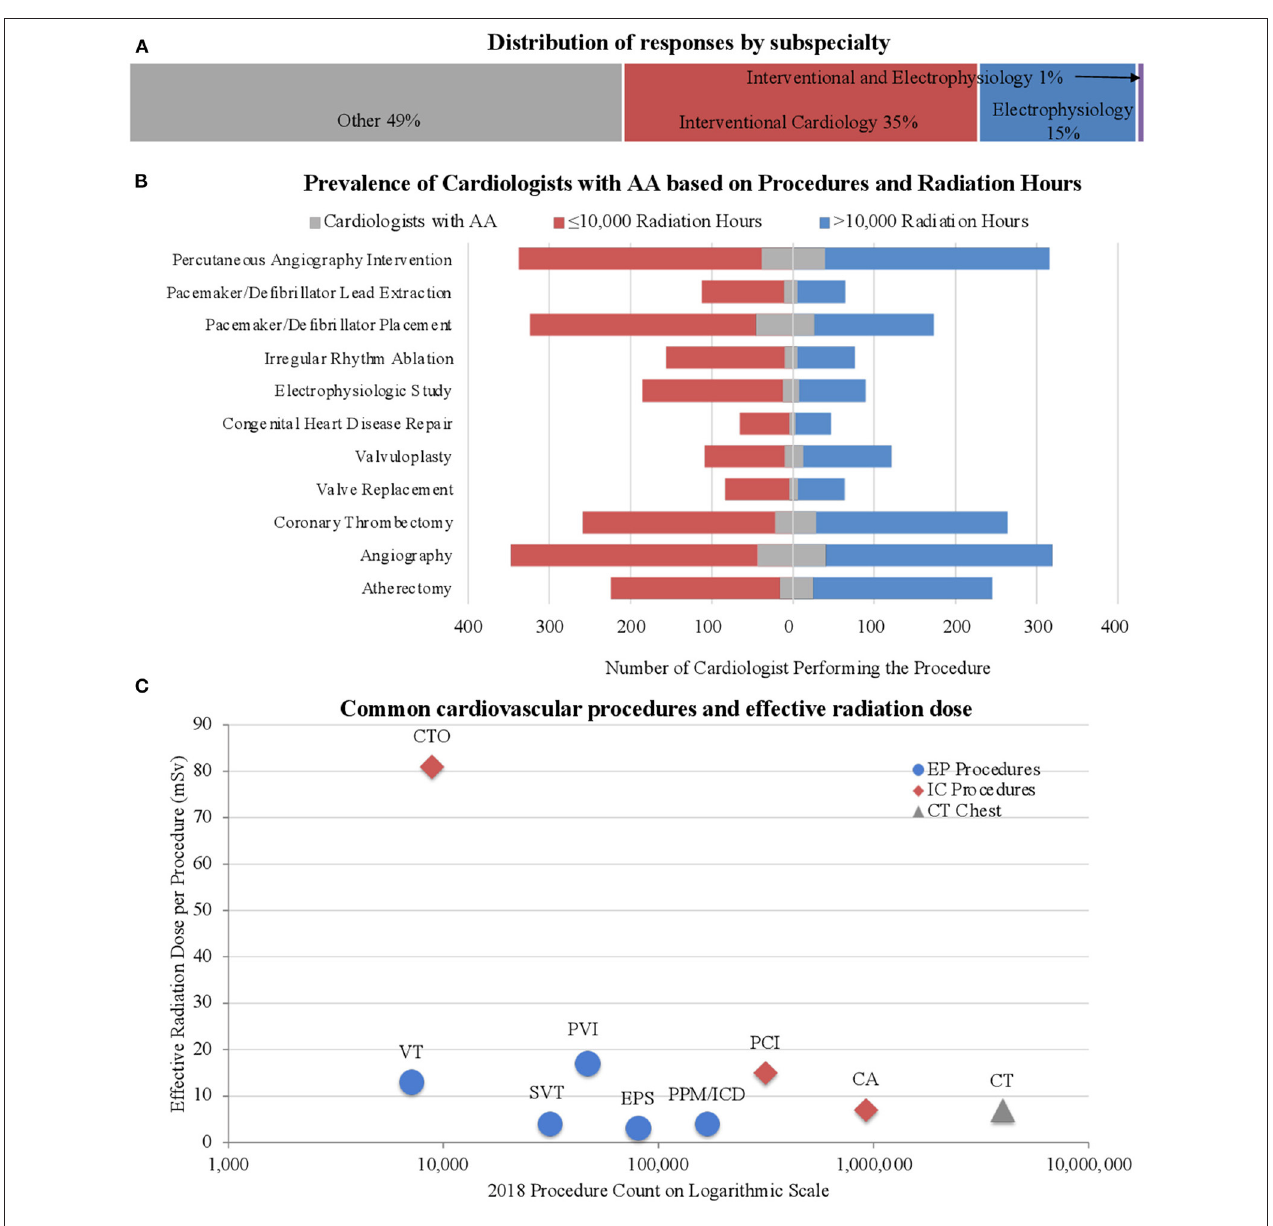
FIGURE 1 | Subspecialty and procedural distribution. (A) Distribution of responses based on subspecialty. Approximately half the respondents were invasive cardiologists. (B) Prevalence of AA among cardiologists based on type of procedure. Note the increased occurrence of AA among those with lower radiation exposure, especially in those performing pacemaker/defibrillator placement. (C) The number of procedures performed in the United States was collected from the 2018 CMS Part B National Summary Data File (18). The effective dose of radiation per procedure was determined through a review of the literature (19, 20). Our survey participants reported procedure frequencies consistent with those found nationwide from the 2018 data as described. The chest CT is depicted as a reference value. CTO, Chronic Total Occlusion; VT, VT ablation; SVT, SVT ablation; PVI, Pulmonary vein Isolation; EPS, EP Study; PPM/ICD, Pacemaker and ICD Placement; PCI, Percutaneous Coronary Intervention; CA, Coronary Angiography; CT, Chest CT